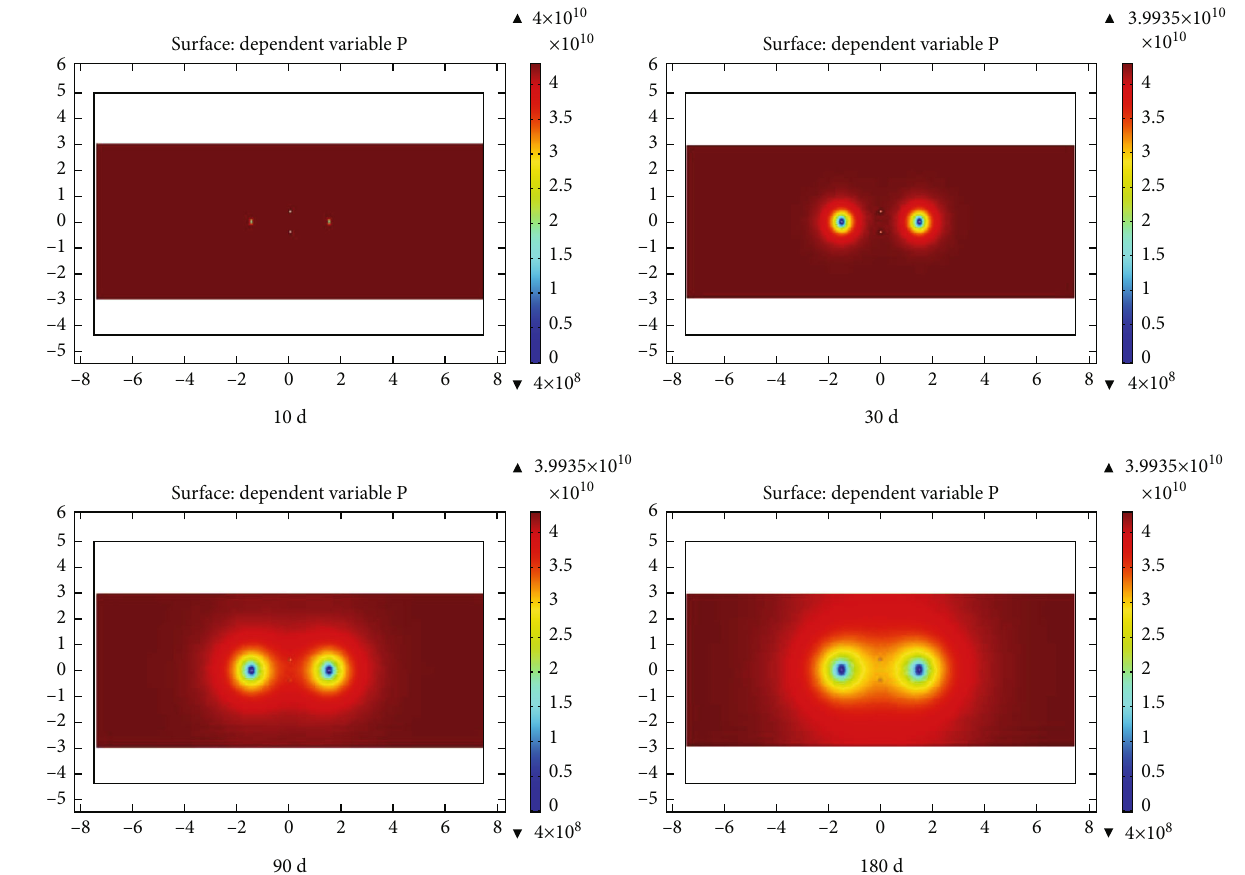
Figure 12: Gas pressure distribution map of liquid carbon dioxide fracturing with 3m spacing between pumping relief is. Within 10 d-90 d of extraction, the gas pressure relief e ff ect of dual-hole fracturing is the most obvious, and then, the radius of gas pressure relief area increases slowly with time and tends to be stable after 180 d. When the spac- ing between the two extraction holes is set to 3 m, good gas extraction e ff ect can be achieved.